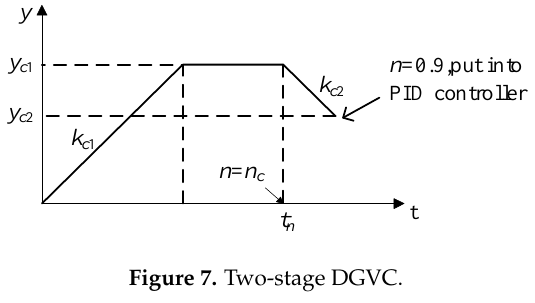
Figure 6. One ‐ stage DGVC. Based on the one ‐ stage DGVC, we can determine the decision variables. As the opening slope is known, only y c can be selected as a decision variable in the first paragraph of Figure 6, and the other three decision variables are three parameters of the PID controller: K p , K i , K d . As can be seen from Figure 3, K i = T i , K d = K id . Thus, the decision variables are denoted as: 1